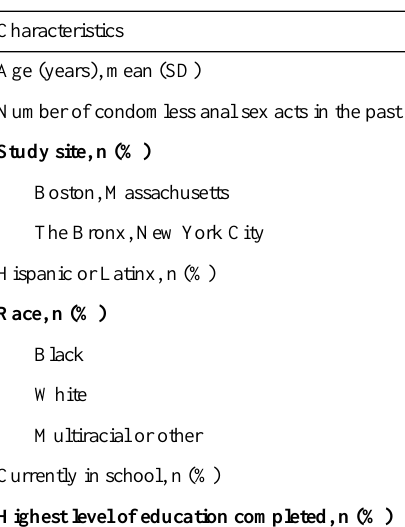
Table 1. Demographic characteristics of participants in theater testing of a novel HIV prevention app for HIV prevention in young men who have sex with men in Boston, Massachusetts, and the Bronx, New York City, 2019